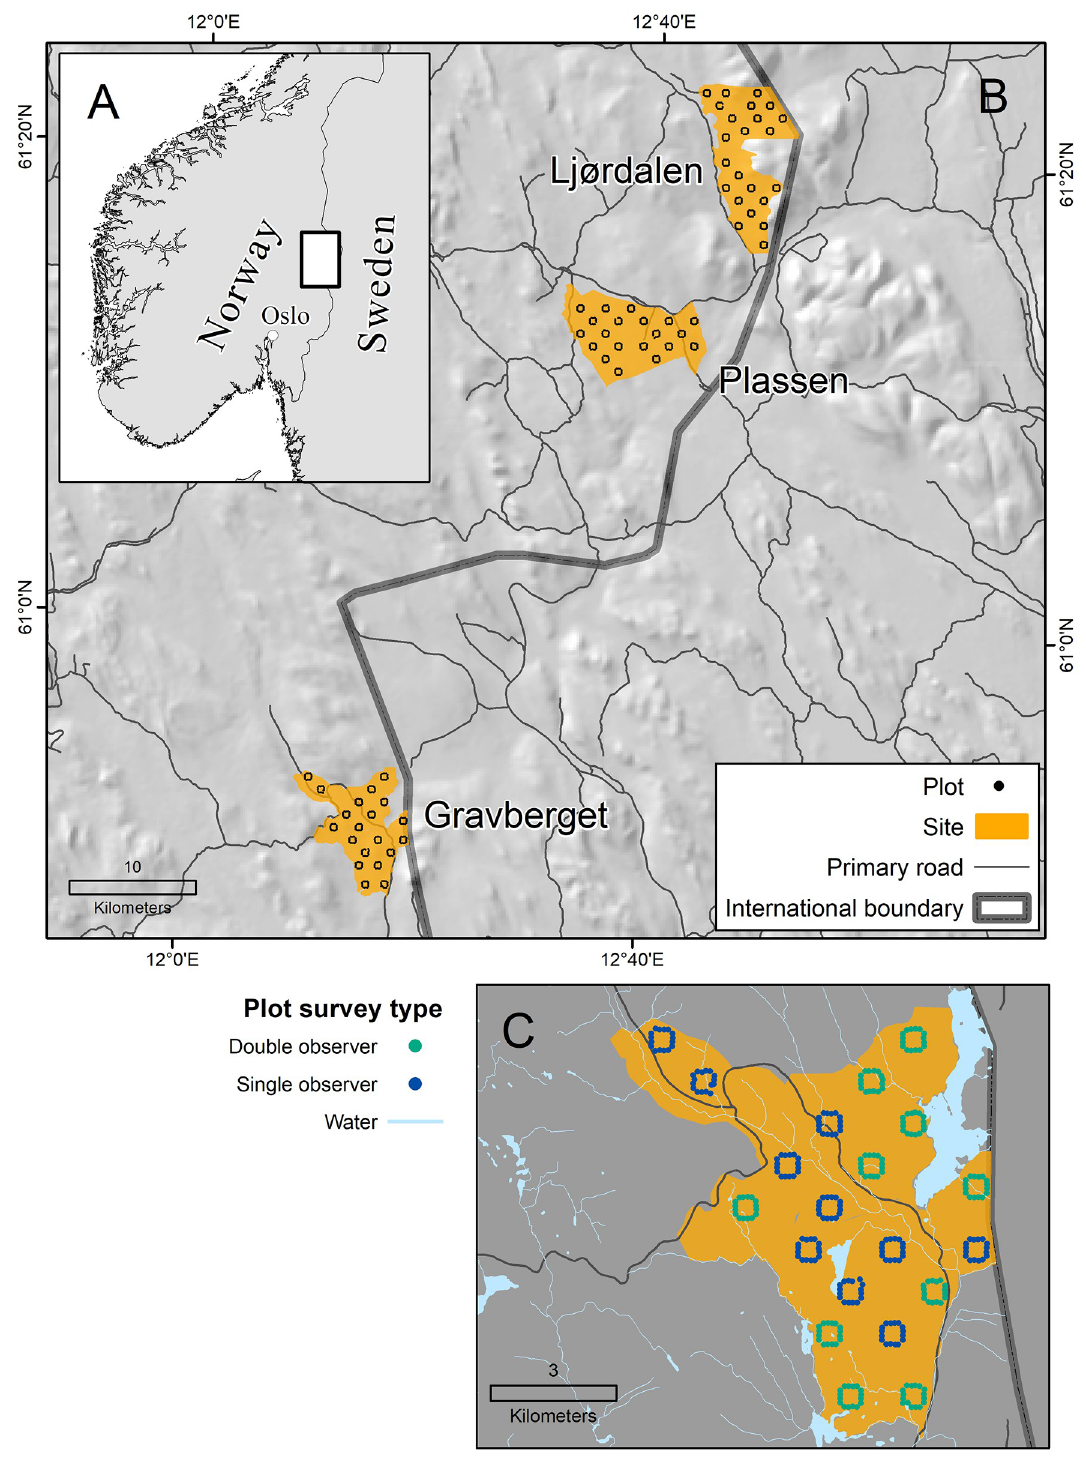
Fig 1. Maps of A) study area in southern Norway; B) each of the three sites (Gravberget, Plassen, Lj ø rdalen) which contained 20–21 quadrats. Background map is a 25-m digital elevation map; C) each quadrat contained 16 plots. A subset of long-term monitoring plots was completed as double observer surveys. Gravberget is shown as an example. Digital elevation maps were reprinted from European Digital Elevation Model (EU-DEM, version 1.1) under a CC BY license, with permission from Copernicus Sentinel Data and Service Information, original copyright